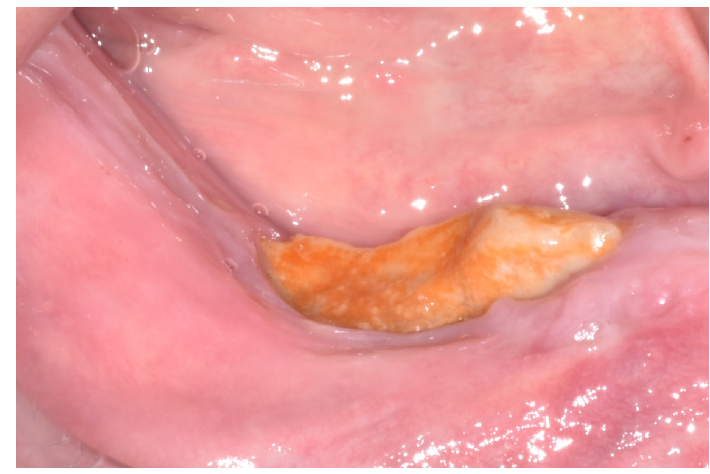
Figure 1. Computed tomography showing mandibular m edication-related osteonecrosis of the jaw.